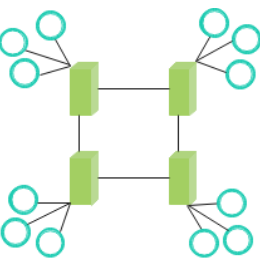
Figure 2. System structure of ring-overlap.